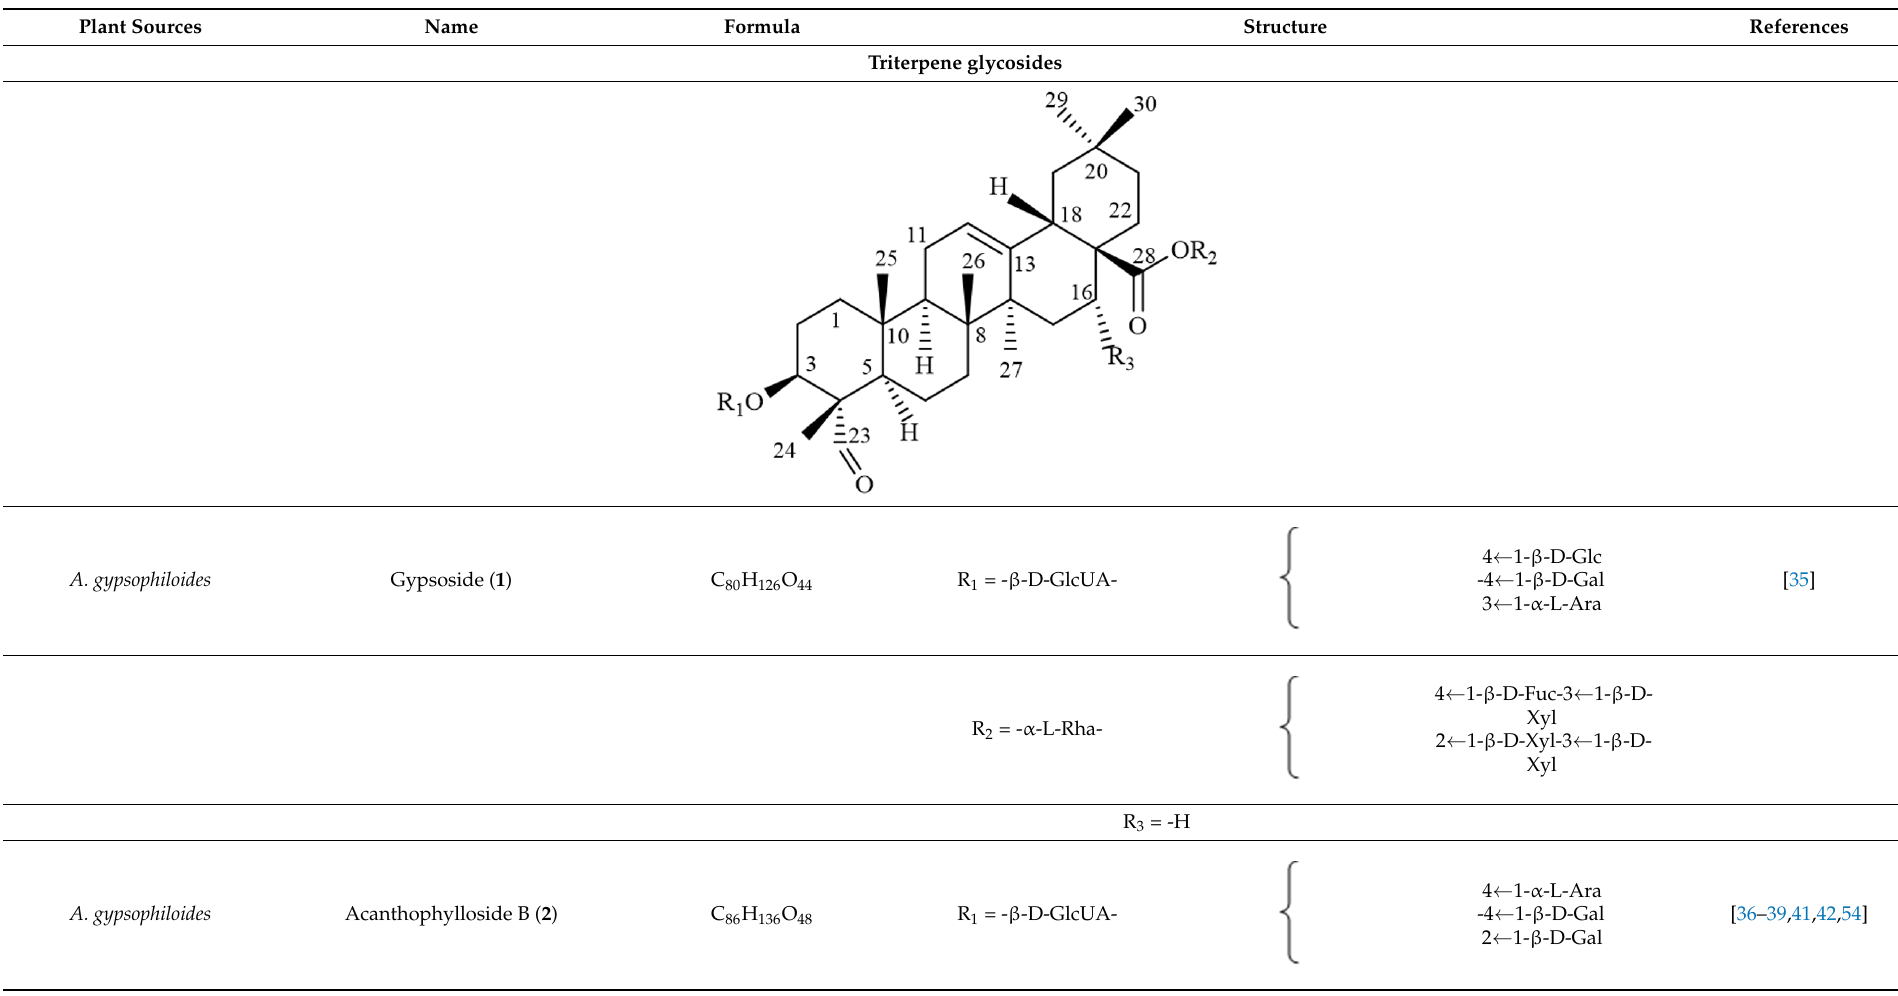
Table 2. Structures and distribution of secondary metabolites in the genus Allochrusa .